Question: What does this figure show? Answer in one sentence.
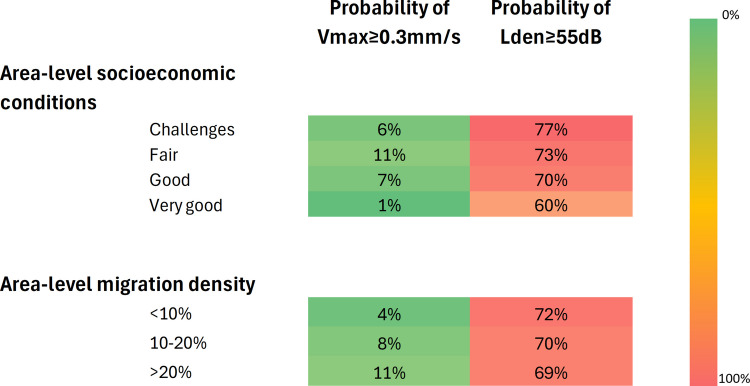
Answer: Colour-coded table of the predicted probabilities of exposure to noise ≥ 55 dB and vibration ≥ 0.3 mm/s Vmax. Probabilities were predicted based on logistic regression models